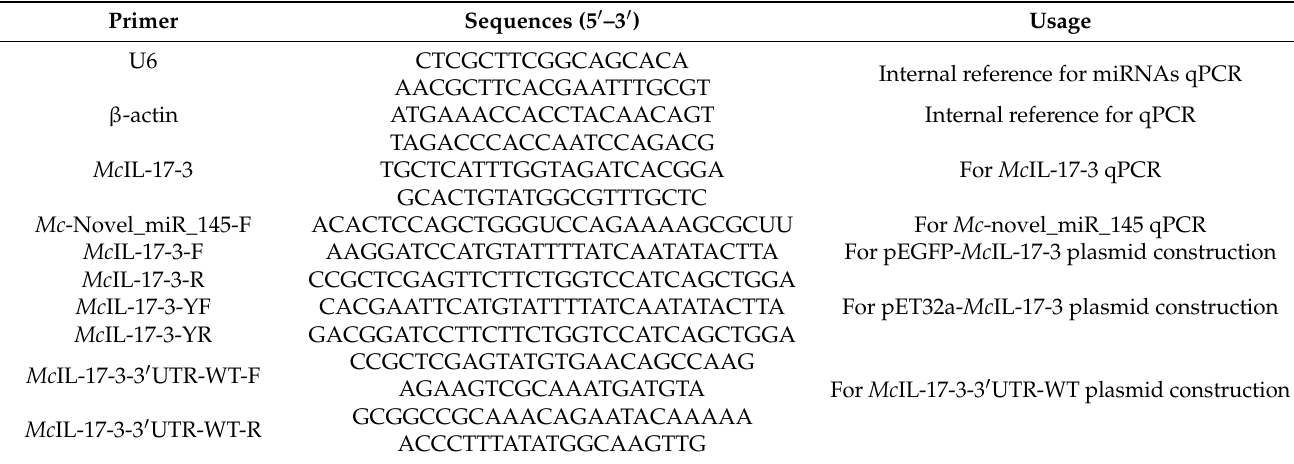
Table 1. PCR primer pairs used in the present